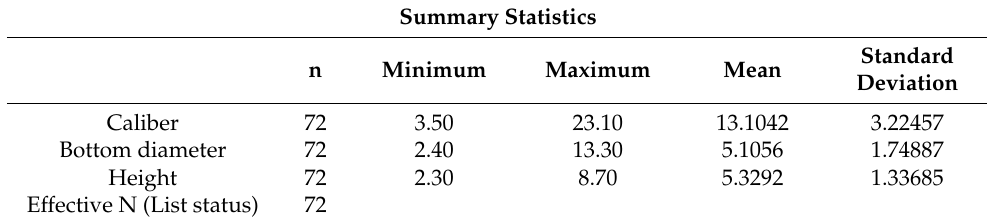
Table 2. Description and statistics of bowl sampling of Xiaopi kiln